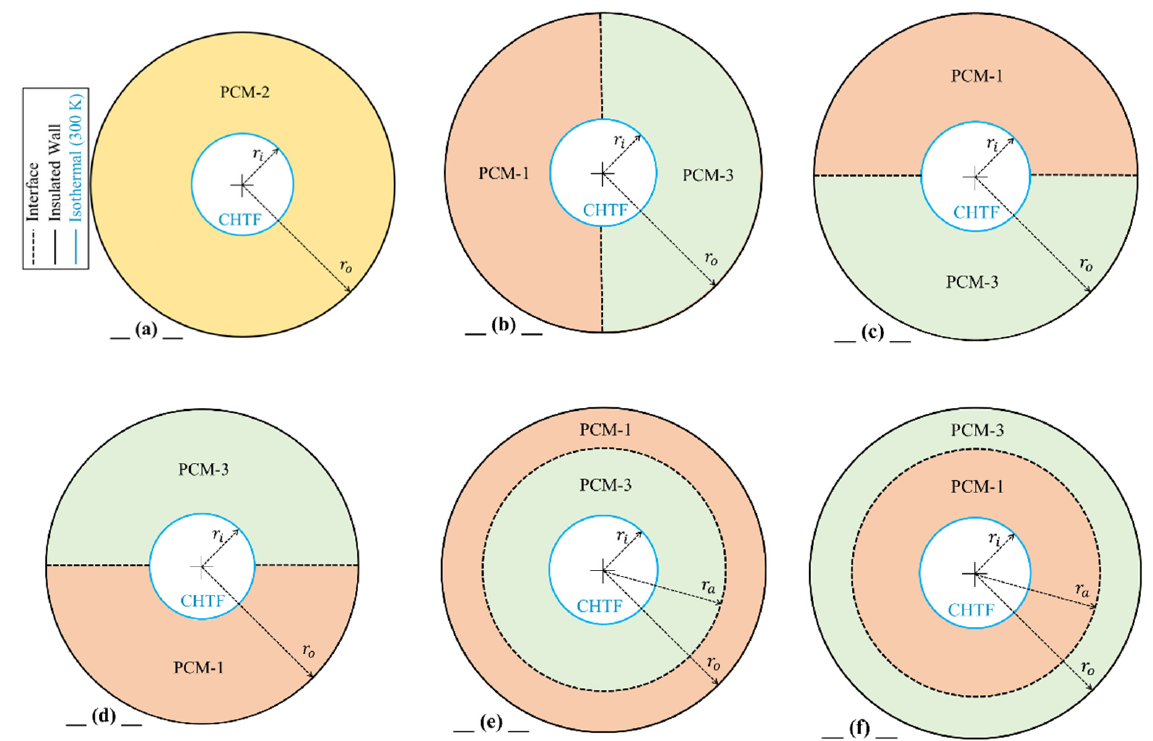
Figure 2. Computational domains in the current study; ( a ) case-1, ( b ) case-2, ( c ) case-3, ( d ) case-4, ( e ) case-5, ( f ) case-6.